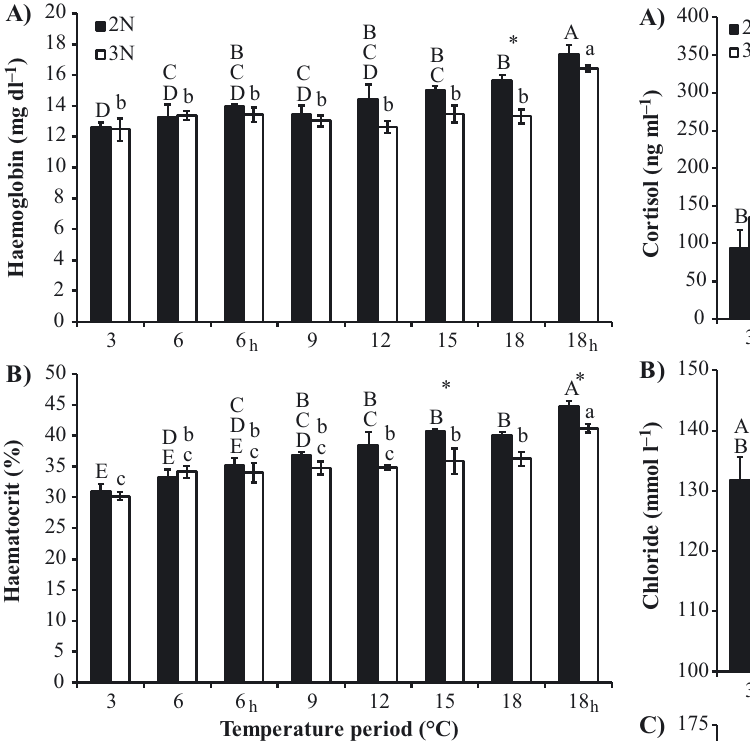
Fig. 5. Mean ± SE blood (A) haemoglobin and (B) haemat- ocrit levels in large diploid and triploid Atlantic salmon Salmo salar in seawater. See Fig. 2 for explanation of symbols